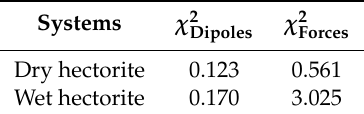
Table 2. χ 2 for the dipoles and the forces for dehydrated and bihydrated hectorite.